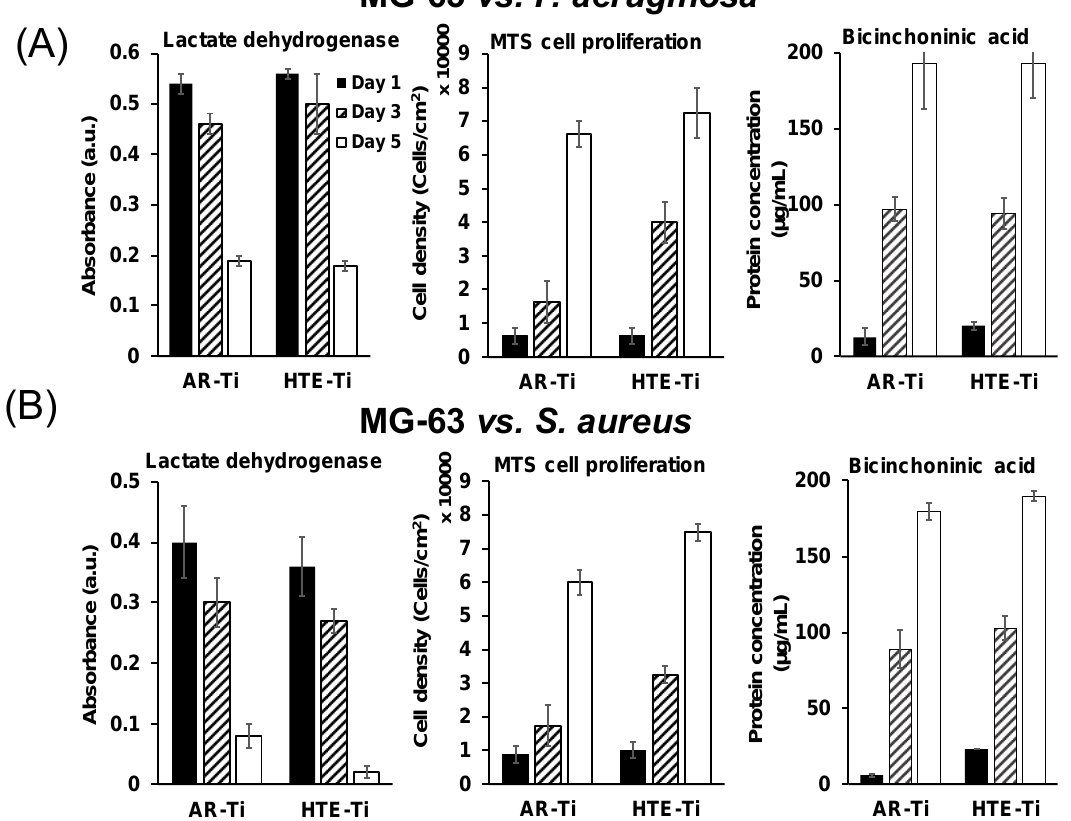
Figure 5. The growth of MG-63 cells on pre-infected surfaces of substrata with ( A ) Pseudomonas aeruginosa and ( B ) Staphylococcus aureus. The lactate dehydrogenase (LDH) assay, which indicates cell damage, showed that the cells had recovered after day 5, which was accompanied by an increase in the cell numbers (MTS cell proliferation assay) and total protein concentration (BCA), in response to their interaction with the pre-infected nanostructured surfaces.